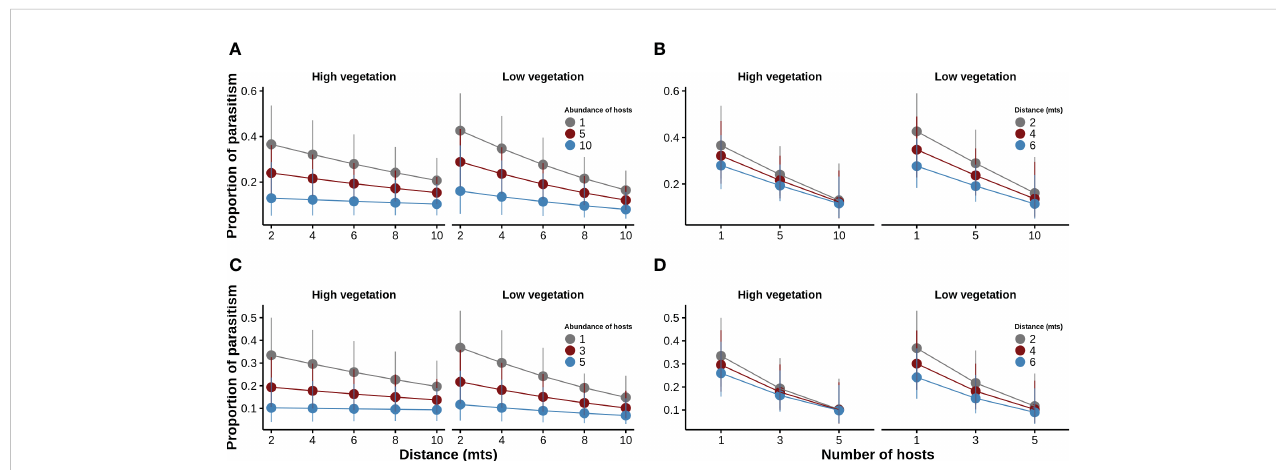
FIGURE 4 The expected proportion of parasitism generated with a generalized linear model assuming a binomial distribution and a logit link function. (A) line model, where the expected proportion of parasitism against distance for different host abundance is shown. (B) line model, showing the expected proportion of parasitism against the number of hosts at different distances. (C) sample model, where the expected proportion of parasitism against distance for different host abundance is shown. (D) sample model, showing the expected proportion of parasitism against the number of hosts at different distances.